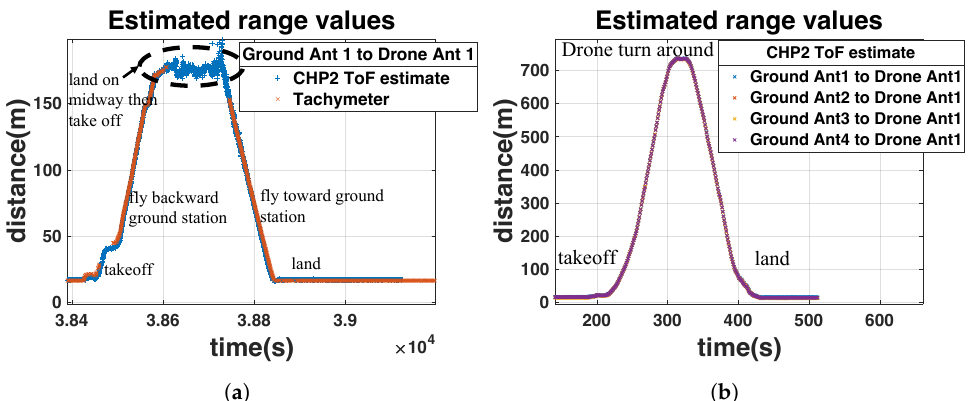
Figure 22. CHP2 ranging estimates for the short- and mid-range tests versus the same tachymeter reference. System performance degrades during the short-range test (left) when line-of-sight (LoS) is obstructed by the operator. The AGC maintains system stability throughout the rest of the experiments. The mid-range test is plotted without a tachymeter reference due to its range limitation (200 m). ( a ) Short-range test. ( b ) Mid-range